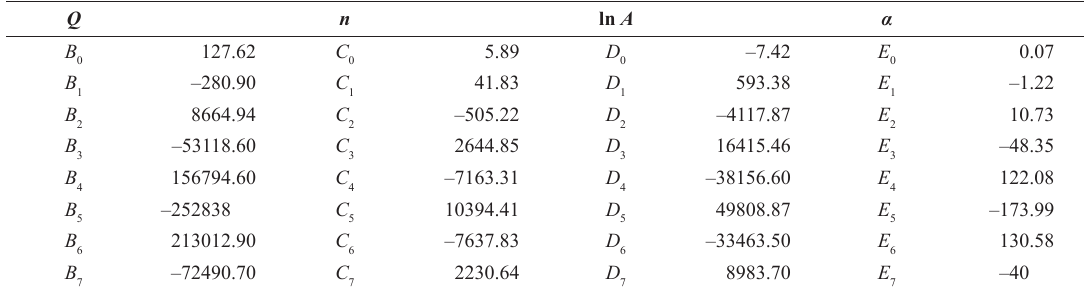
Table 2. Polynomial fitting results of Q , n , ln A and α for AZ80